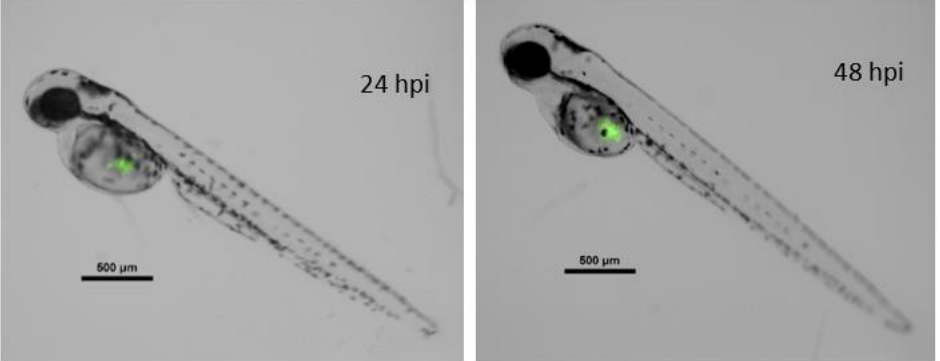
Figure 8. Merged composition (black/white and green fluorescence channels) of a zebrafish embryo xenografted with fluorescent MCF7 cancer line. Left image, 72 hpf zebrafish at 24 hpi. Right image, the same embryo 24 h later. hpi = hours post injection; hpf = hours post fertilization. Scale = 500 µm.